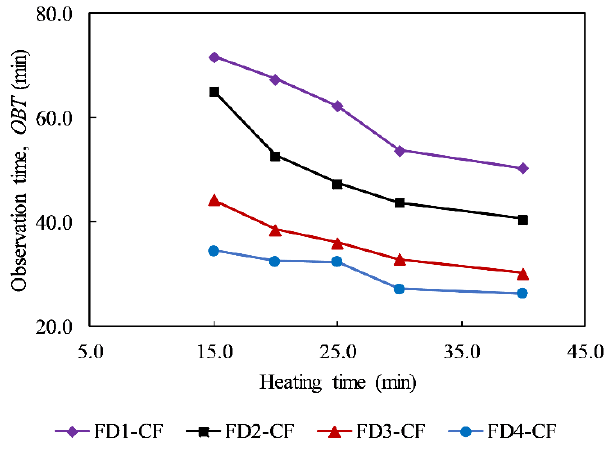
Figure 9. Observation time of delaminations.